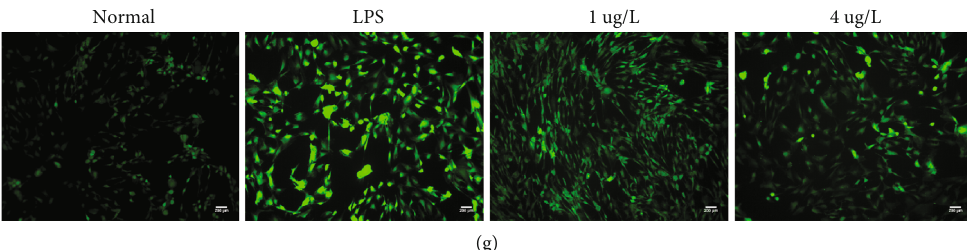
Figure 6: SP-NEs modulate AMPK-mTOR activity in LPS-stimulated FLSs. (a) Di ff erent concentrations of SP-NEs on cell viability. (b).The contents of IL-1 β and IL-18 in the supernatant of FLSs in each group. (c). Typical protein bands of AMPK α and p-AMPK α , in FLSs for each group. (d) Relative protein level of AMPK α and p-AMPK α for each group. ∗∗ P < 0 : 01 vs. the normal, # P < 0 : 05 vs. the KOA, ## P < 0 : 01 vs. the KOA, P = 0 : 09 , comparison between the underlined two groups. (e) Typical protein bands of mTOR and p-mTOR in FLSs for each group. (f) Relative protein level of mTOR and p-mTOR in each group. ∗∗ P < 0 : 01 vs. the normal, ## P < 0 : 01 vs. the KOA, P = 0 : 09 , comparison between the underlined two groups. (g) DCFH-DA probe labeled ROS to re fl ect mitochondrial function and green fl uorescence intensity indicated ROS